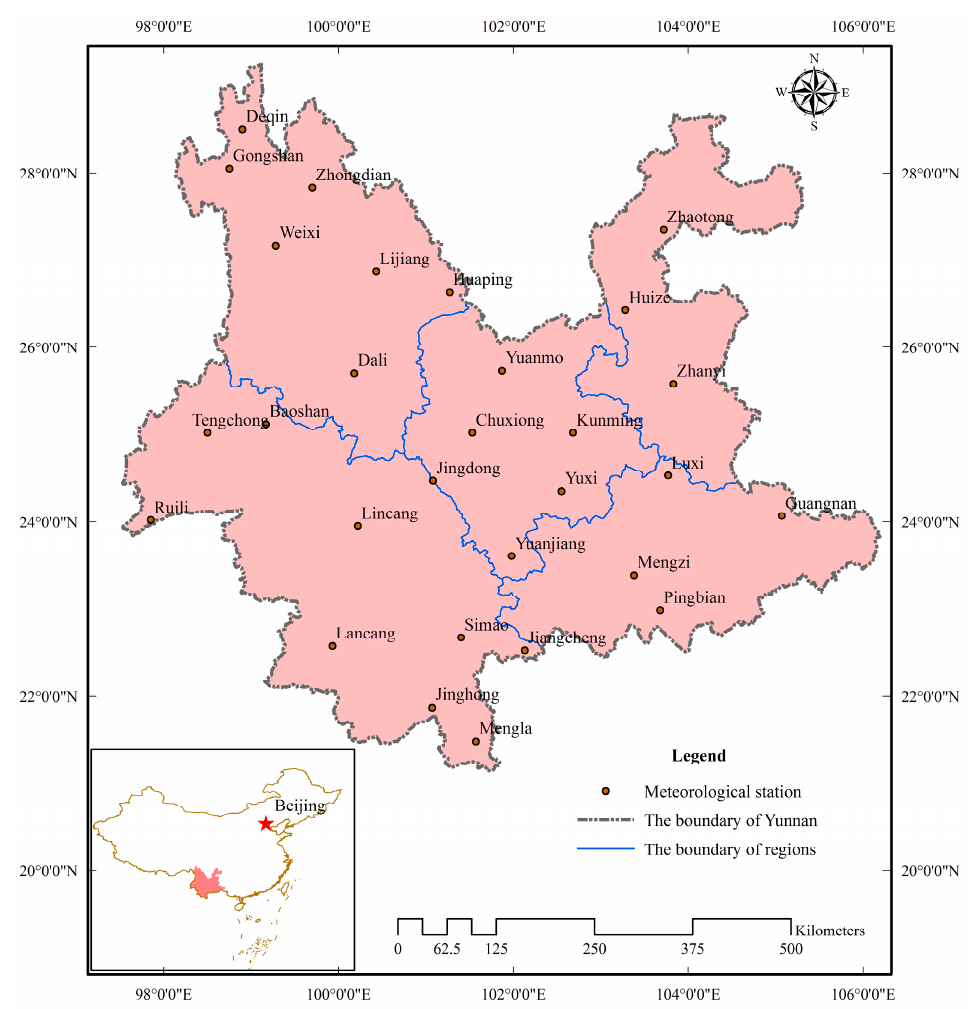
Figure 1. The location of the meteorological stations in Yunnan Province.